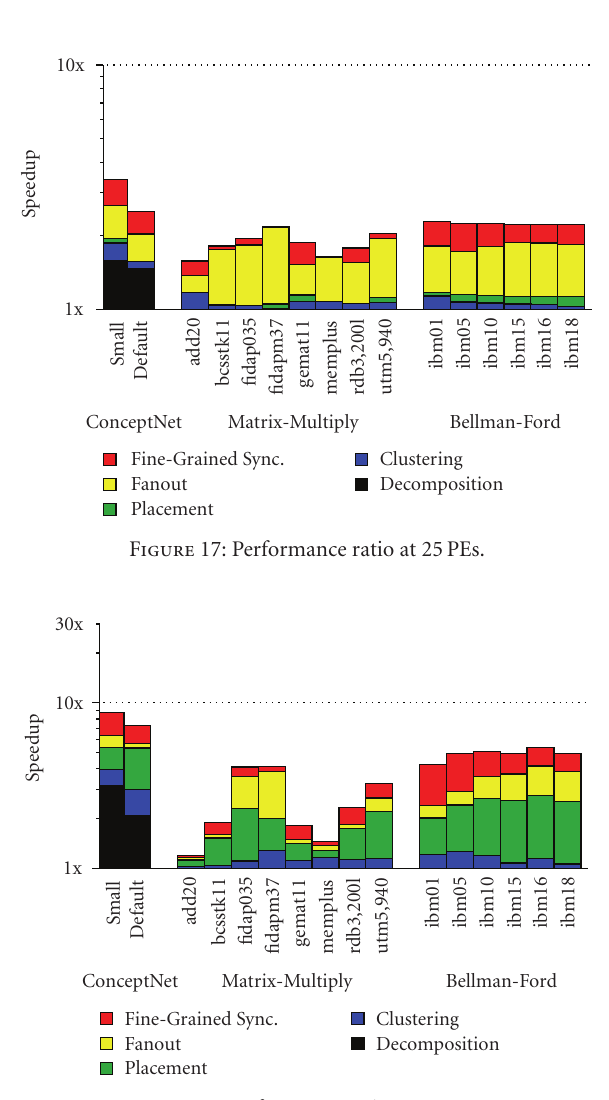
Figure 18: Performance ratio at 256 PEs.